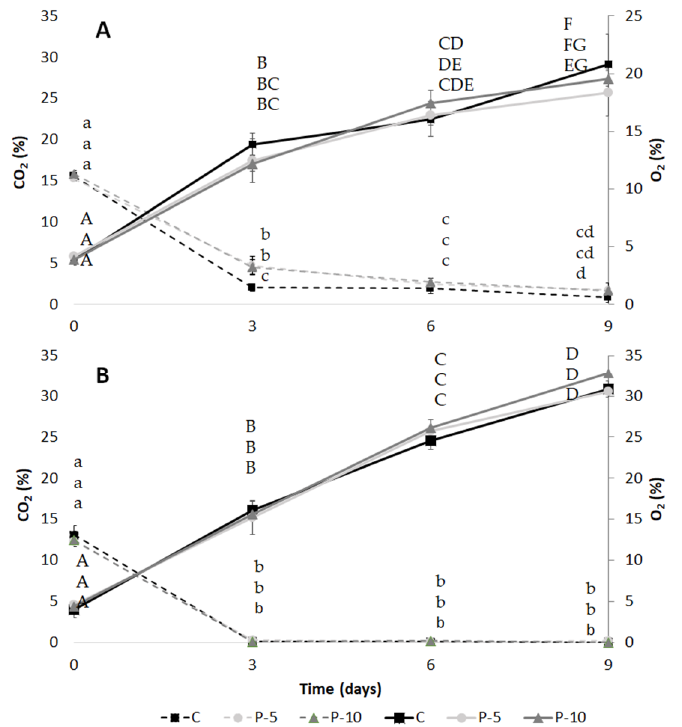
Figure 6. O 2 (dotted lines) and CO 2 (solid lines) concentration in the headspaces of PP ( A ) and PET ( B ) packages of fresh-cut apples subjected to 5 (P5) and 10 (P10) min of plasma exposure compared with the untreated ones. Different lowercase and uppercase letters indicate significant differences ( p < 0.05) among O 2 and CO 2 values, respectively.